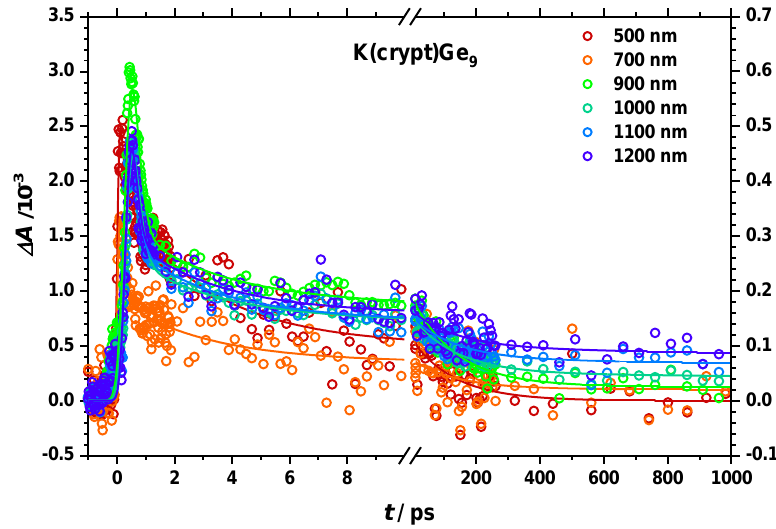
Figure 4. Transient response after 267/258 nm excitation at different wavelengths (circles) for K(crypt)Ge 9− in THF. On a long timescale one can see that the values continuously increase with longer wavelengths. Fit curves are displayed as lines.